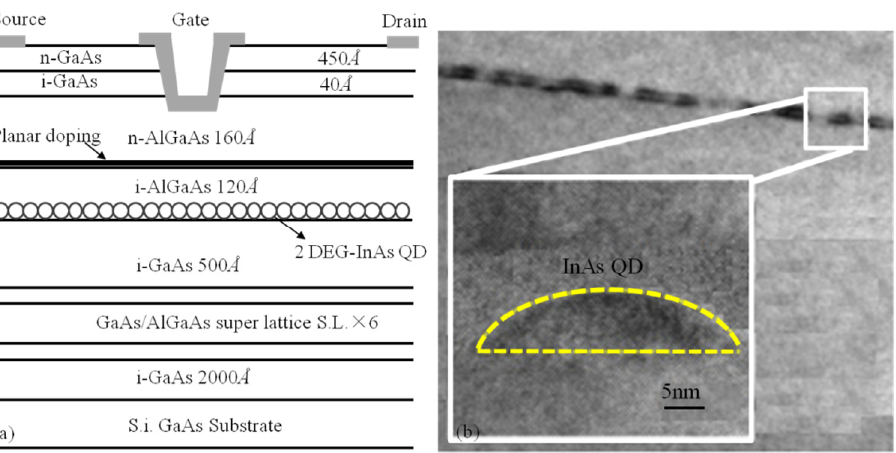
Figure 1. ( a )The schematic of InAs QD-HEMT structure ( b ) The cross-section TEM of